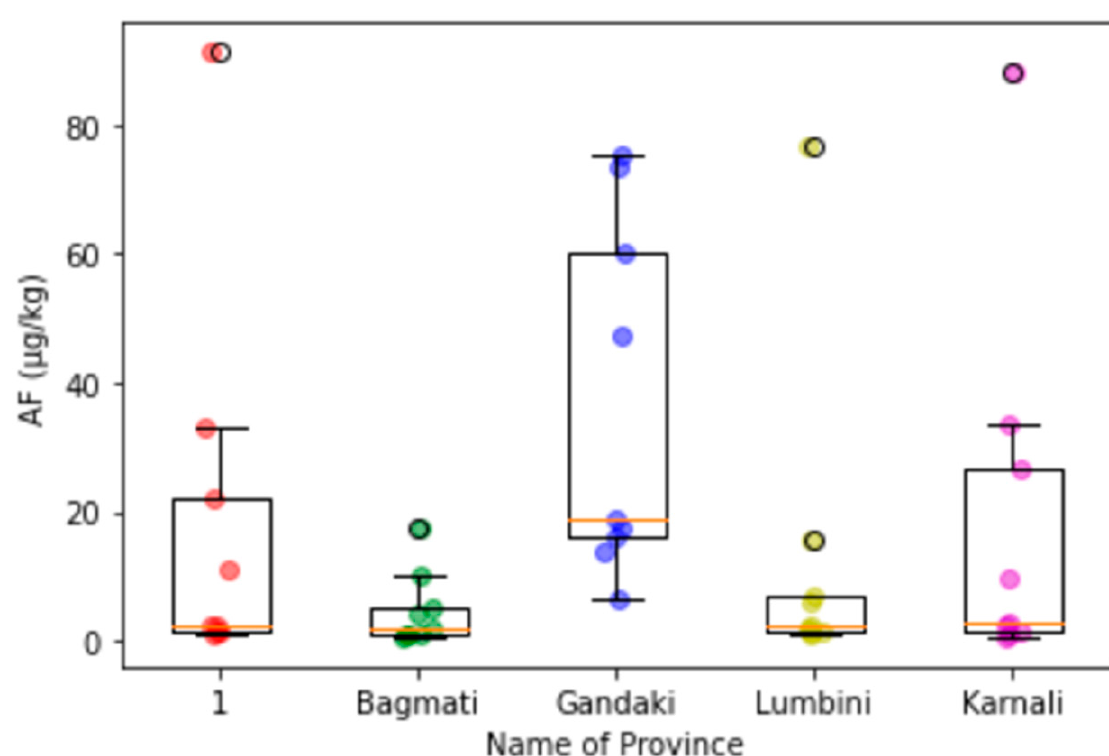
Figure A11. Contamination level of